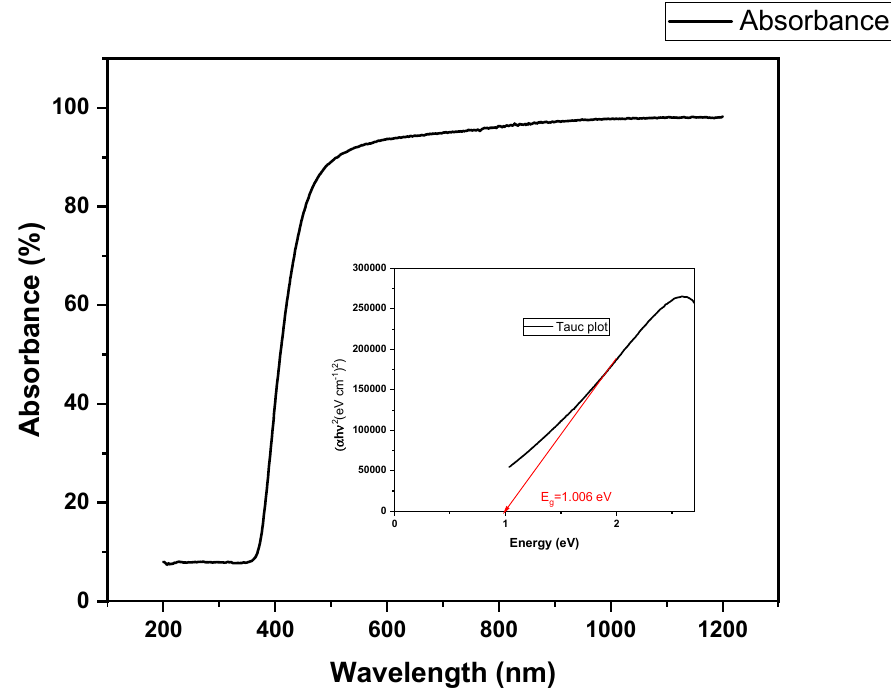
Figure 1. UV-Vis spectroscopy DRS of Sg -CuO NPs with Tauc plot for calculating the excitation energy.